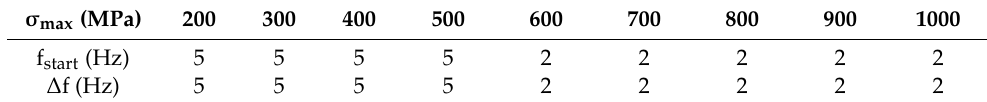
Table 1. Parameters for multiple frequency tests for laminate dependent self-heating investigation. σ max